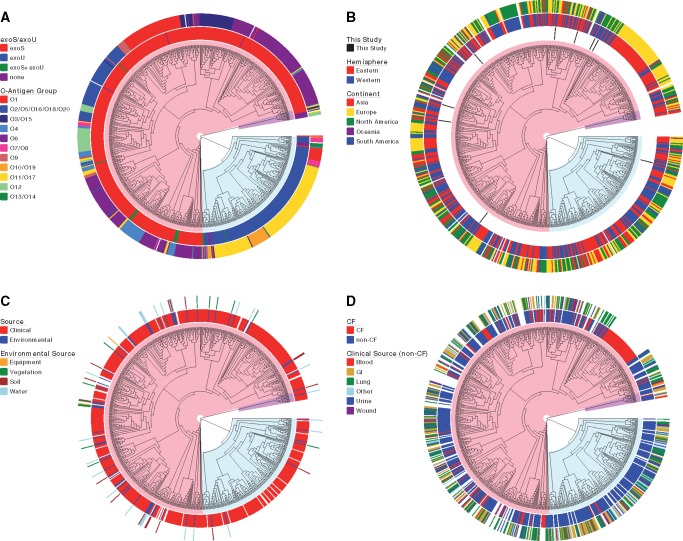
—Isolate demographic and accessory genome characteristics. Each panel shows 95% core genome maximum likelihood trees with isolate information highlighted. Trees are displayed as phylograms with branch lengths that do not correspond to genetic distances. Major clonal groups are highlighted in red (Group A), blue (Group B), and purple (Group C). (A) Accessory genome characteristics. Inner ring: Presence of type III effector genes exoS and exoU. Outer ring: O-antigen biosynthesis locus type. (B) Geographic source of isolates. Inner ring: isolates sequenced as part of this study. Middle ring: global hemisphere of isolation. Outer ring: continent of isolation. (C) Source of environmental isolates. Inner ring: environmental versus clinical isolates. Outer ring: specific sources of environmental isolates. (D) Source of clinical isolates. Inner ring: CF versus non-CF clinical isolates. Outer ring: body site of isolation for the non-CF isolates.